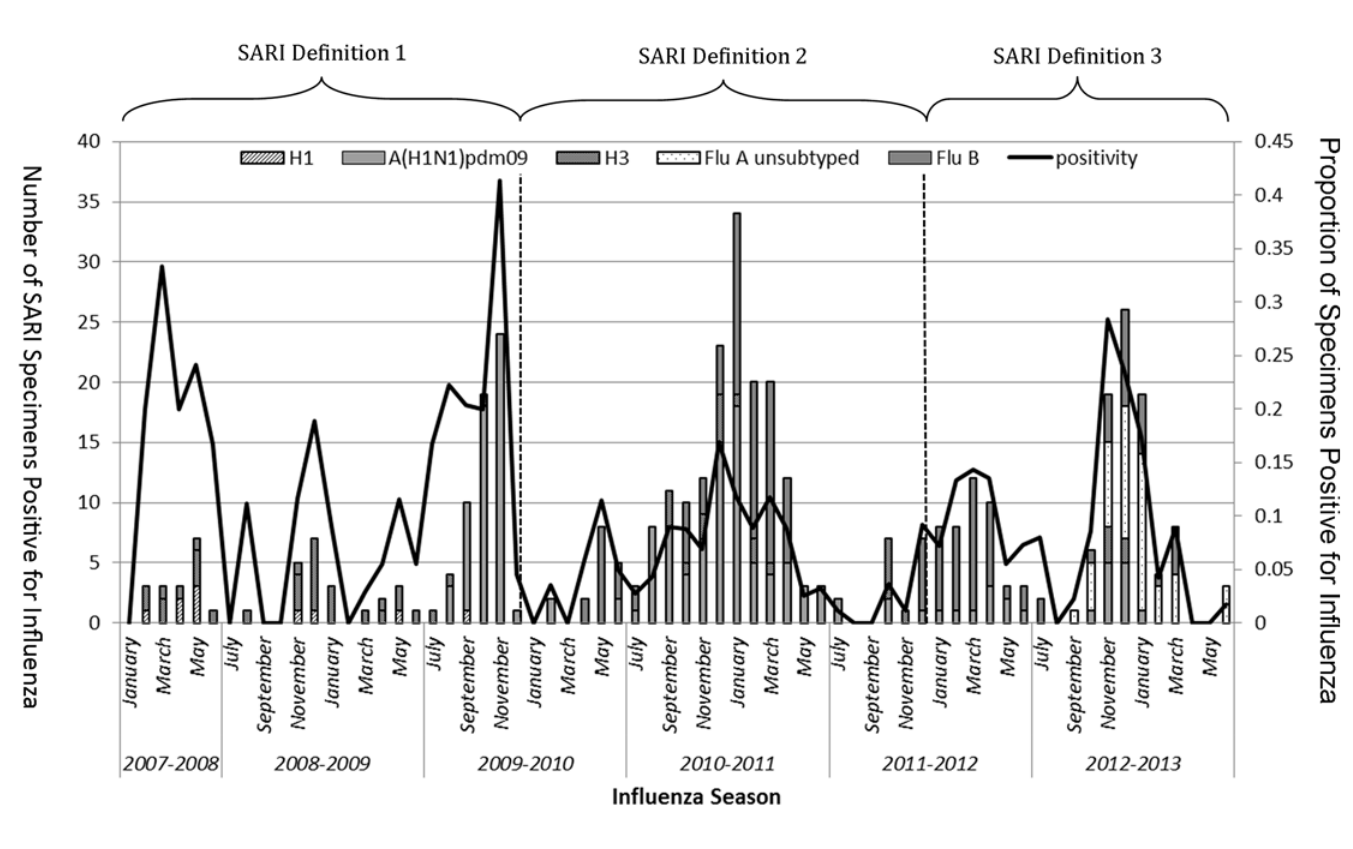
Fig 1. Number of patients enrolled in sentinel surveillance for severe acute respiratory infections by month, Sultanate of Oman, January 2008-June 2013.